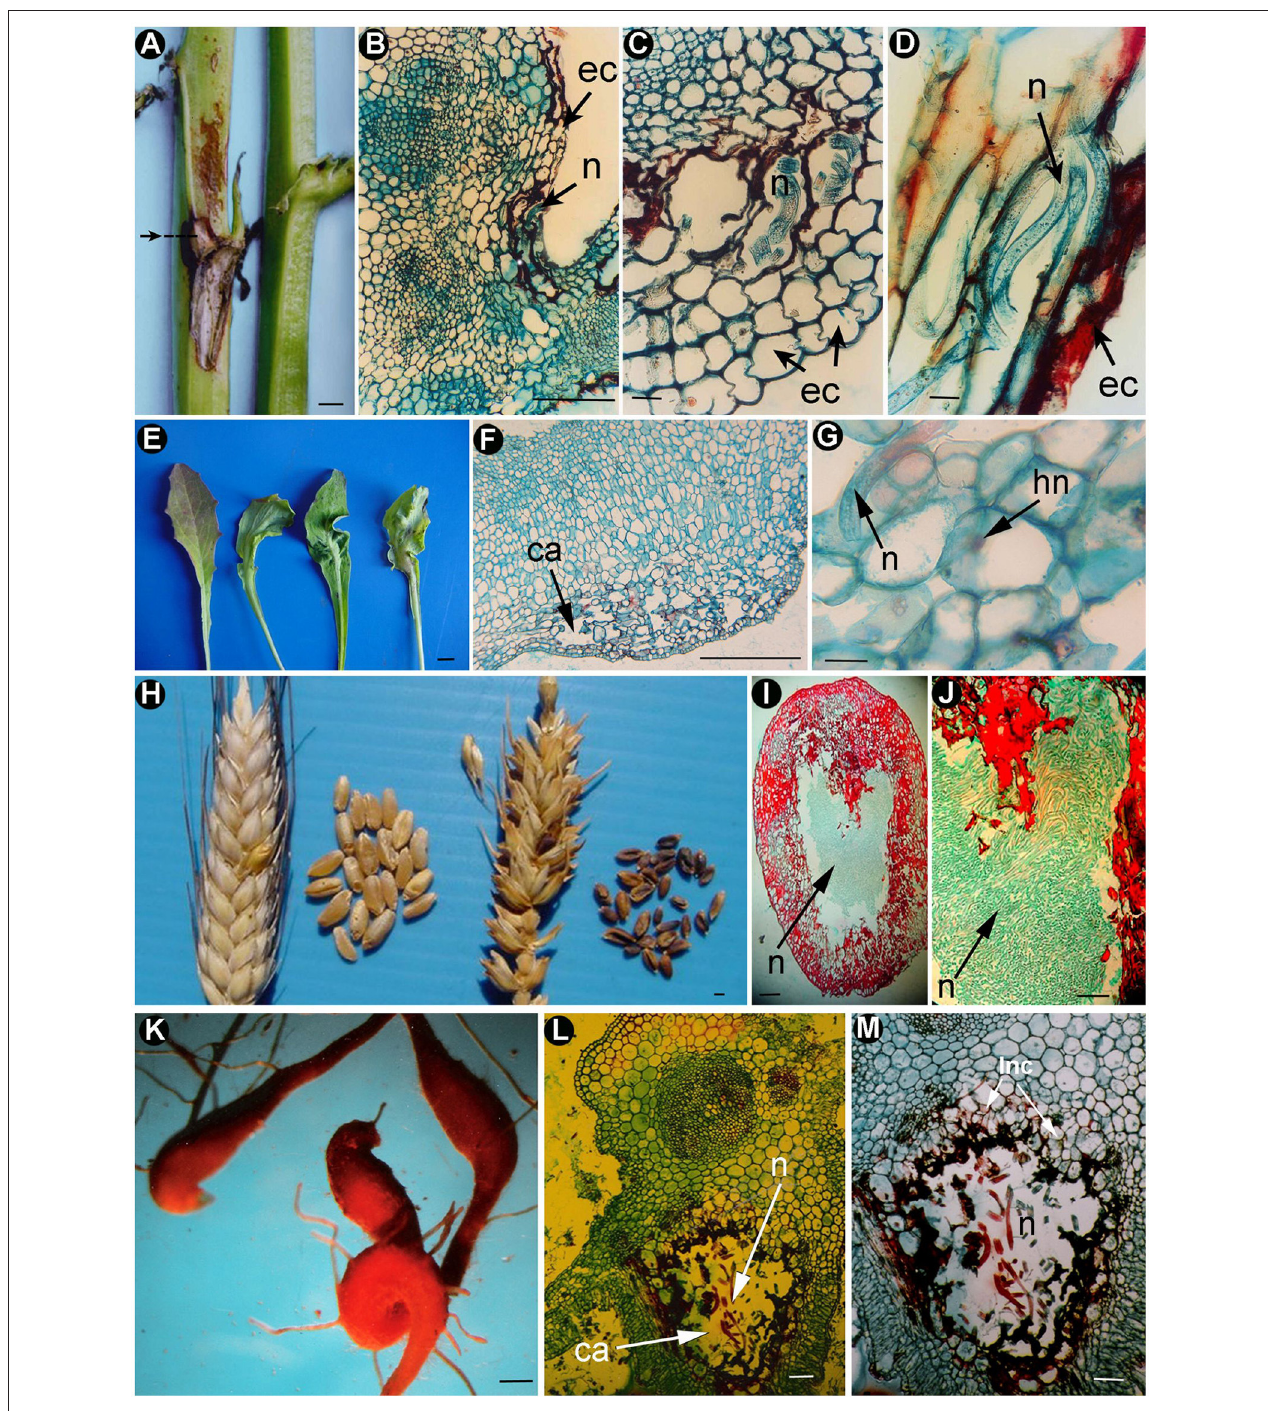
FIGURE 1 | Morphogenesis caused by stem, leaf, seed and root gall nematodes. Ditylenchus gigas (A–D) : (A) Necrotic area on stem (arrowed). (B–D) Cross sections of parenchymatic tissues of the stem showing under-epidermic cavities surrounded by necrotic cells and nematode body portions (Vovlas et al., 2011; with permission of John Wiley and Sons). Ditylenchus oncogenus (E–G) : (E) Leaf midrib nematode-induced galls, showing different deformation degrees. (F) Longitudinal section of parenchyma of a stem portion showing sub-epidermal cavities (ca) surrounded by necrotic cells. (G) Cross-section of flower parenchyma showing a nematode (n), and hypertrophied nuclei (hn) in the attacked cells (Vovlas et al., 2015b; with permission of Cambridge University Press). Anguina tritici (H–J) : (H) Healthy (left) and infected (right) spike and seed galls of wheat. (I,J) Cross-sections of wheat-seed showing severe infection induced by the nematode (n) and the high number of nematodes inside the grain (Source: N. Vovlas). Root-galls caused by Subanguina radicicola (K) on Poa annua (Source: N. Vovlas). Subanguina moxae (L,M) : Cross-sections of foliar galls from Artemisia sp. showing cavities (ca), nematodes (n), and a layer of nutritious cells (lnc) (Source: N. Vovlas). ca, cavity; ec, epidermic cell layer; hn, hypertrophied nuclei; lnc, layer of nutritious cells; n, nematode. Scale bars: A,F,H,K = 1,000 µ m; B,E = 500 µ m; C,D,G,J = 50 µ m; I,L,M = 100 µ m.